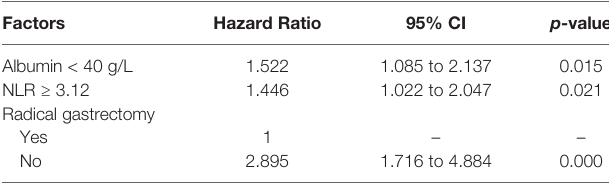
TABLE 2 | Multivariable Cox regression